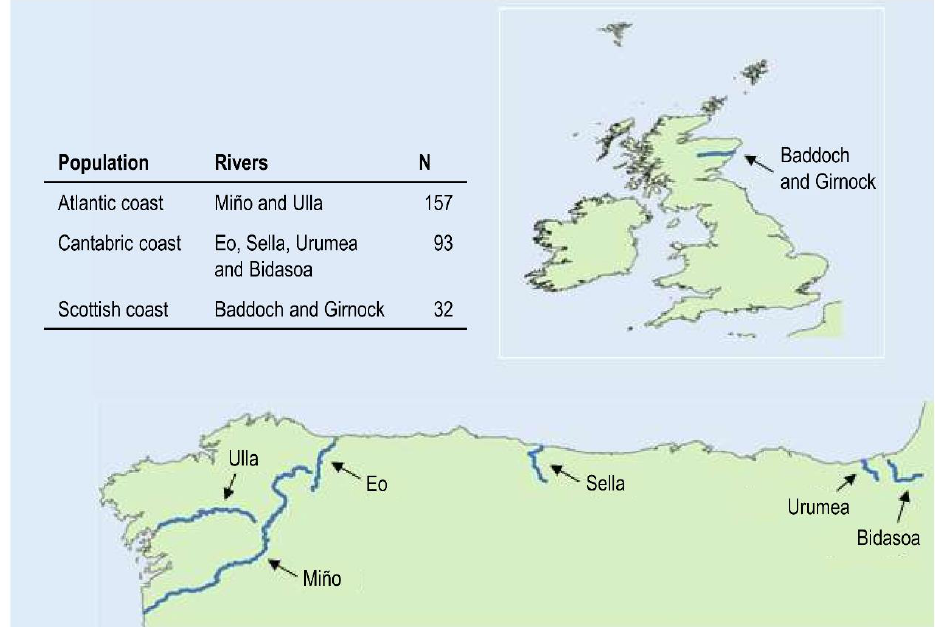
Figure 1. Origin and number of samples analysed: 250 individuals from six rivers in the Iberian Peninsula (Miño, Ulla, Eo, Sella, Urumea and Bidasoa), covering the entire distribution of salmon in its southern boundary, and 32 individuals from two Scottish rivers (Baddock and Girnock), tributaries of the Dee River.